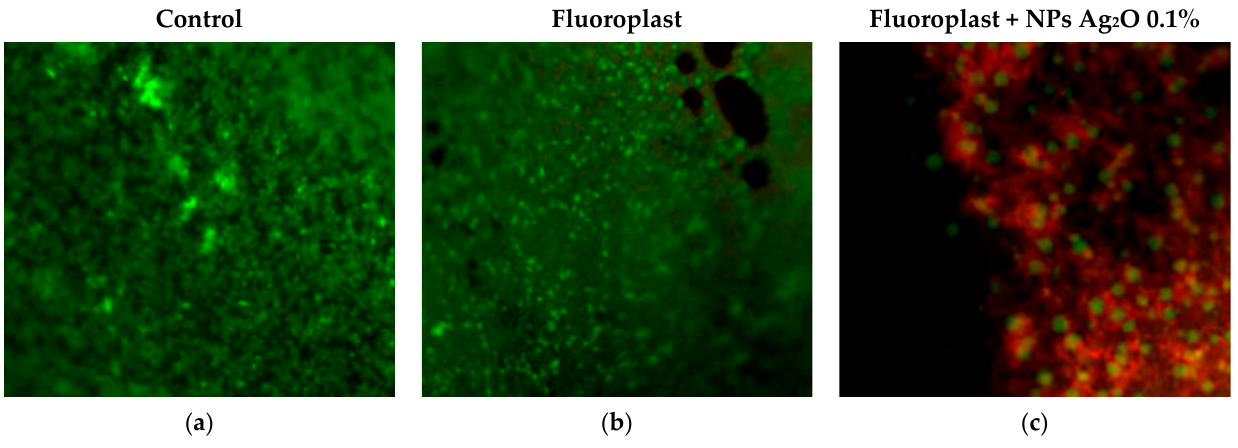
Figure 8. Evaluation of the survival of P. aeruginosa on uncoated samples ( a ), on PTFE without NPs ( b ), and on the composite coating of fluoroplast / NP Ag 2 O 0.1% ( c ). Living cells are colored green, dead cells red. Magnification × 400.